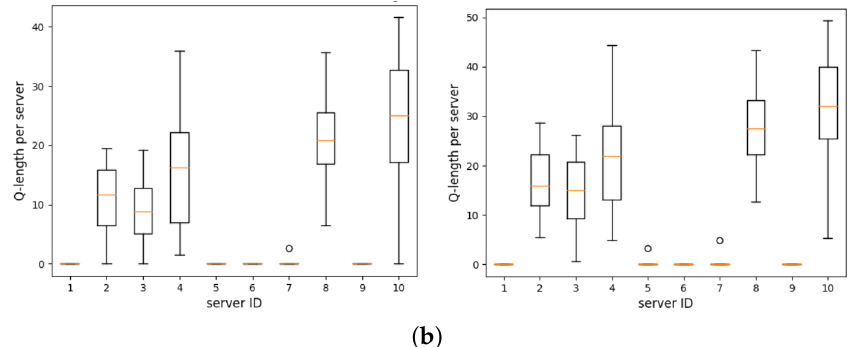
Figure 11. Length of the queue per server for 10 MECSs with workload rate = 1.0. ( a ) The neighbor- hood range is 4 ( q th = 0.5 or 0.7); ( b ) The neighborhood range is 6 ( q th = 0.5 or 0.7).